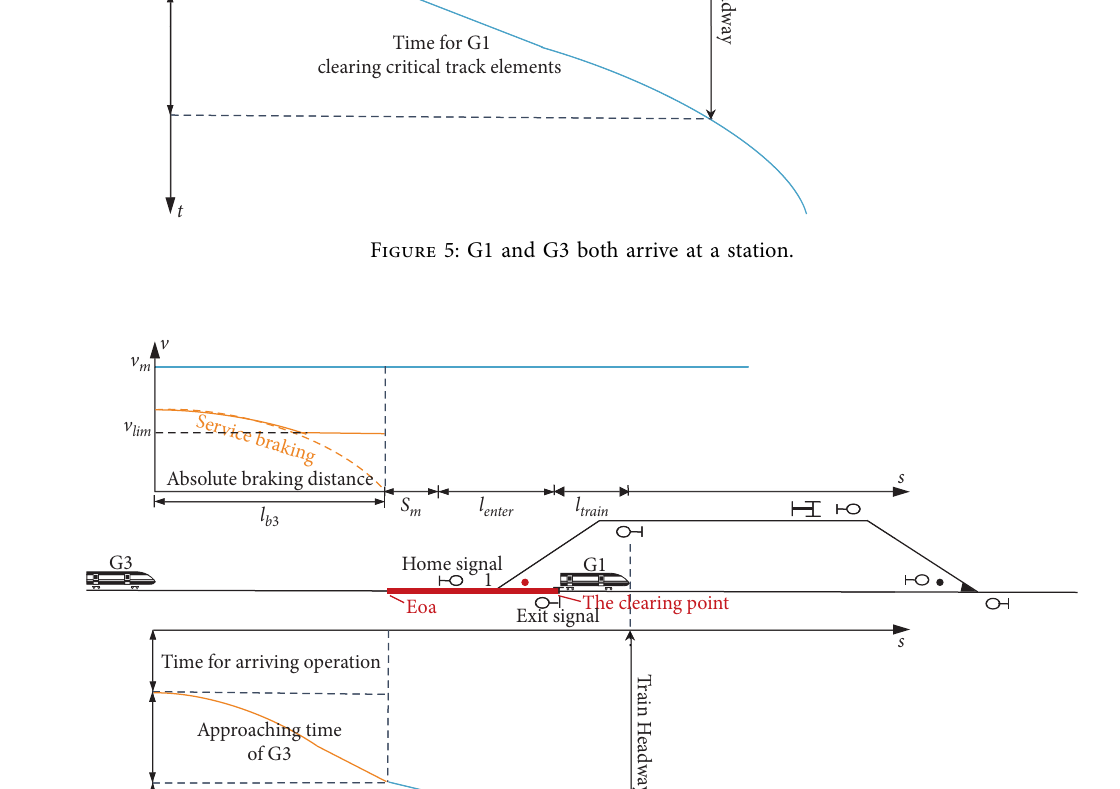
Figure 6: G1 passes through the station and G3 arrives at the